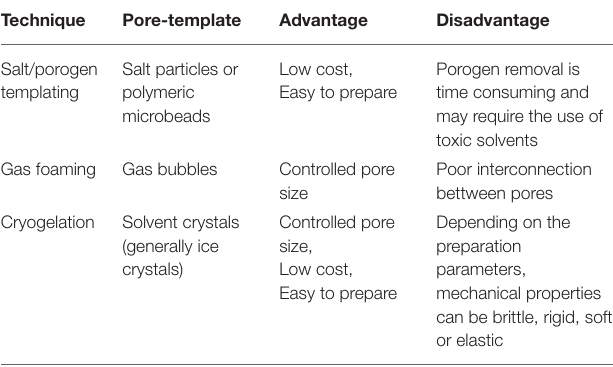
TABLE 1 | Different techniques used for macroporous gel